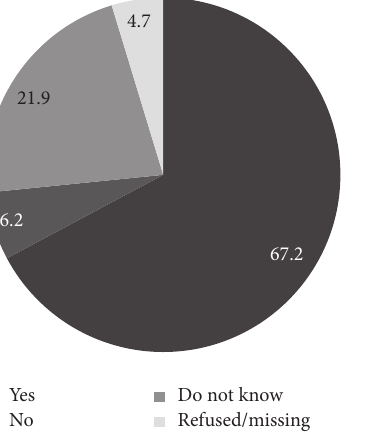
Figure 1: Aware that HPV results from sex with infected partner, among those who have heard of HPV, Odisha, India ( 𝑛 = 64 ).